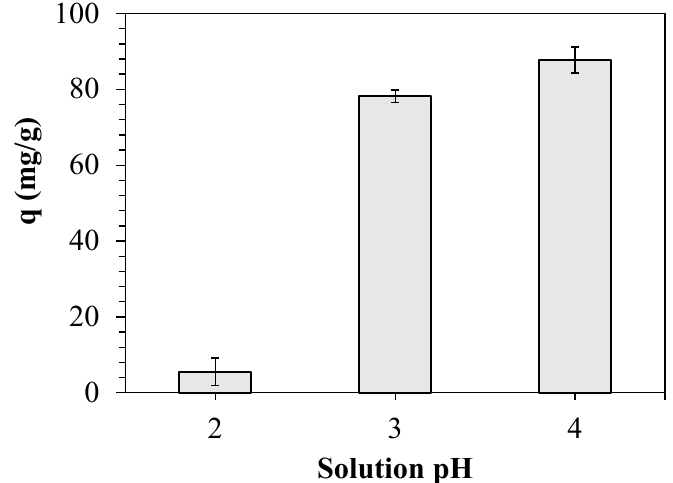
Figure 6. Effect of solution pH on adsorption of Cu(II) ions. Here, q denotes the adsorption capacity.